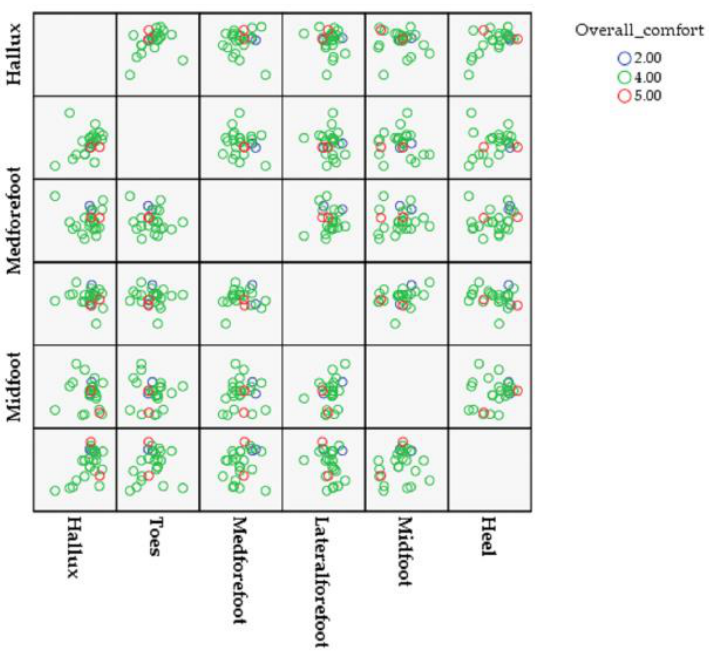
Figure 7. Pearson’s correlation coefficients between overall comfort and plantar foot Figure 7. Pearson ’ s correlation coefficients between overall comfort and plantar foot pressure. Table 4. Pearson correlation coefficients ( r ) and p-values ( p ) for overall comfort and plantar foot pressure.